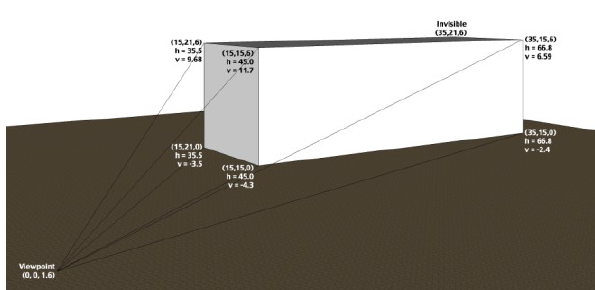
Figure 5. Visual Angle Computation Method for Buildings: Bounding Box is used and calculation is for each vertex, only max and min of horizontal or vertical value is